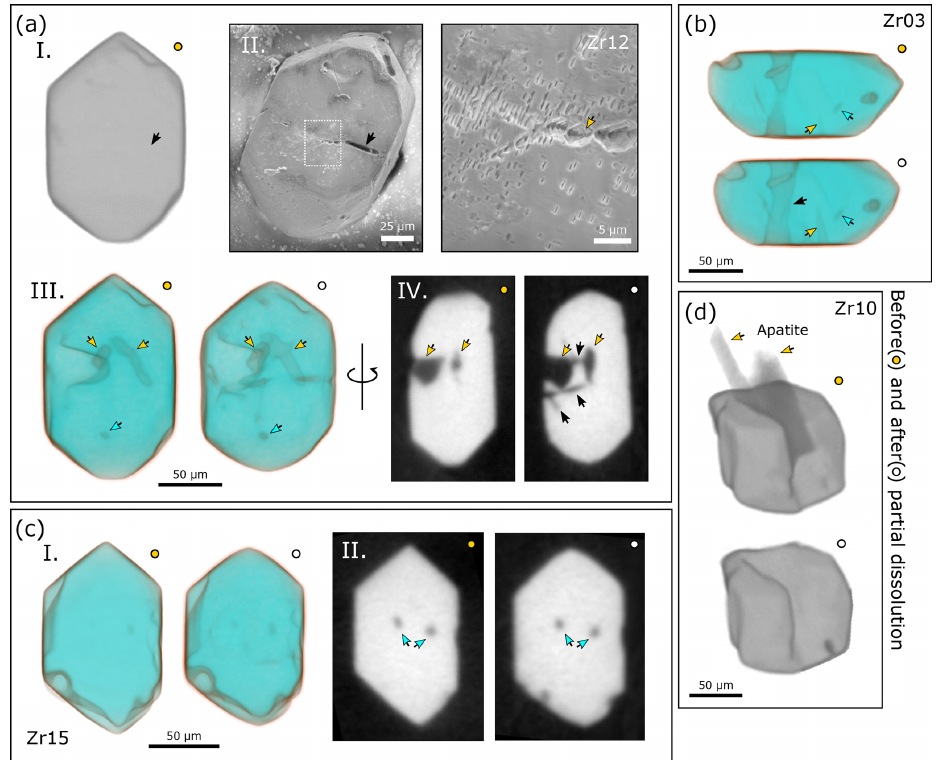
Figure 16. SE and µCT images of BOM2A grains pre- and post-chemical abrasion at 180 ◦ C for 12h. (a) Subpanel (I) shows an opaque 3D rendering of µCT data for Zr12. (II) SE image of a grain surface with a close-up image of clustered and isolated rectangular etch pits. The black arrow points to a void in the crystal, perhaps related to a surficial inclusion not apparent in the pre-chemical abrasion dataset, and the yellow arrow highlights another interesting dissolution feature. (III) Semi-transparent 3D rendering of µCT data showing inclusions removed by partial dissolution (yellow arrows) and inclusions inferred to have survived (teal arrows). (IV) 2D µCT image slices with yellow arrows depicting inclusions dissolved during chemical abrasion and black arrows highlighting acid paths. (b) Semi-transparent 3D rendering of µCT data for Zr03, showing inclusions removed by partial dissolution (yellow arrows) and inclusions inferred to have survived (teal arrows). The black arrow highlights an acid path cutting through the crystal interior. (c) Subpanel (I) shows a semi-transparent 3D rendering of µCT data for Zr15, suggesting a slight shortening along the c axis. (II) 2D µCT image slices showing inclusions inferred to have survived partial dissolution. (d) Opaque 3D rendering of µCT data for Zr10 showing the removal of large, protruding apatite inclusions by partial